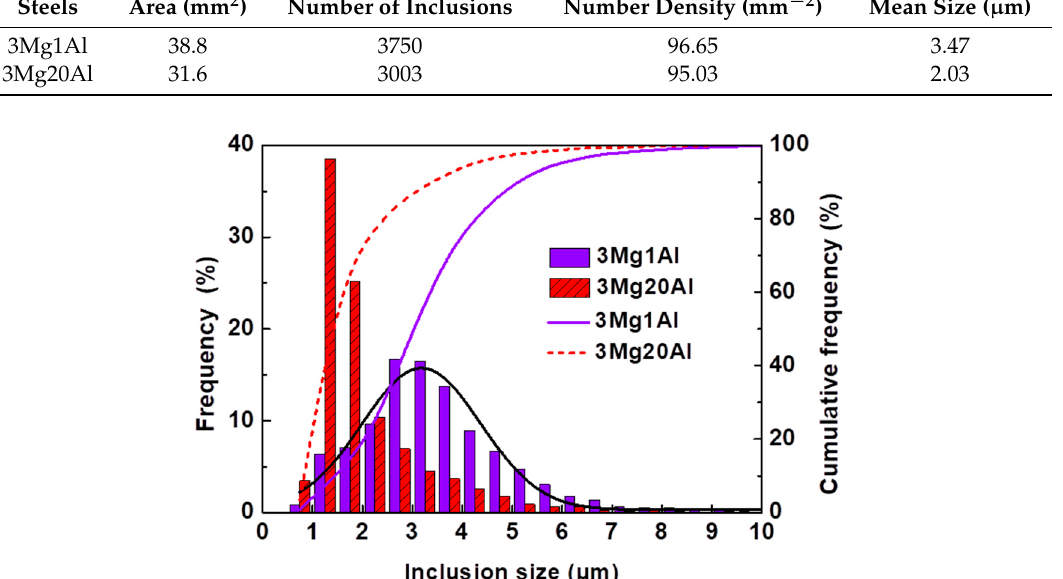
Figure 5. Size distribution of inclusions in experimental steels.